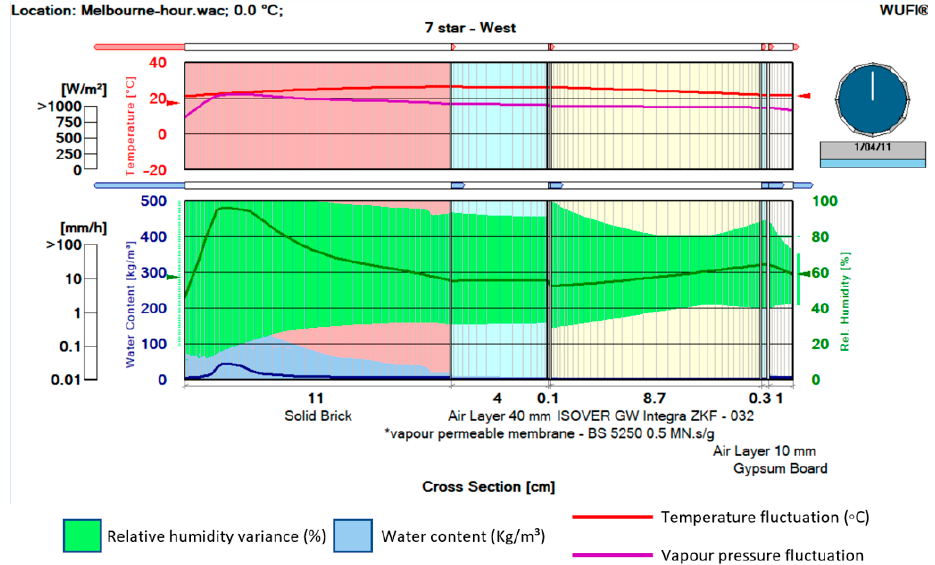
Figure 10. Graphical output of the 7 − star clay masonry veneer wall with a vapour-permeable membrane in a temperate climate—north orientation—10 years.